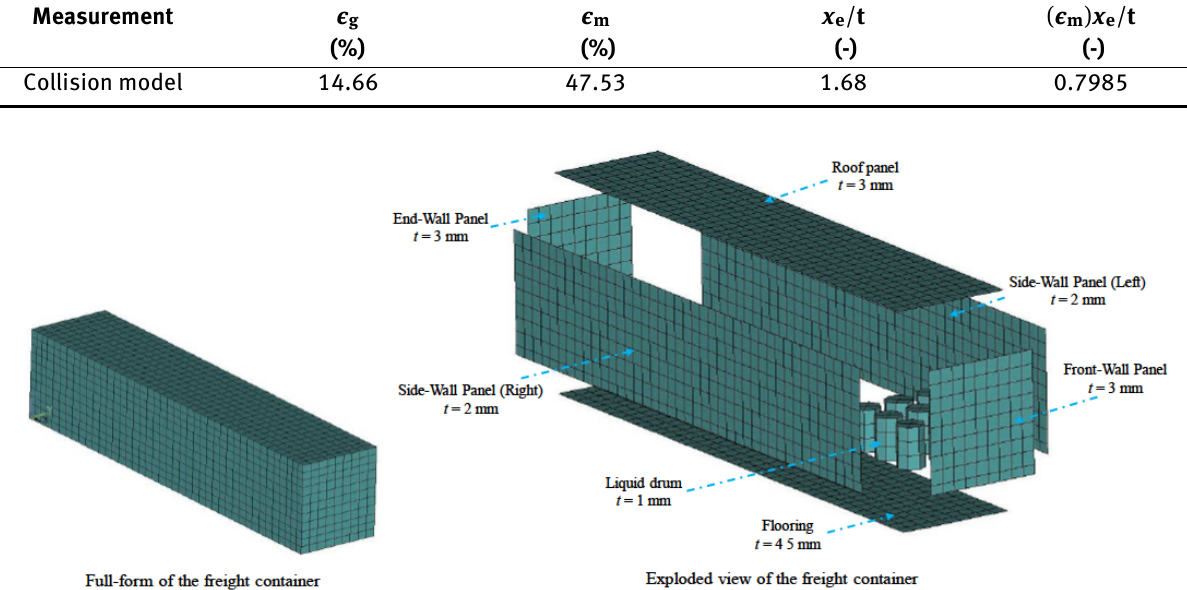
Figure 4: Container design for the collision